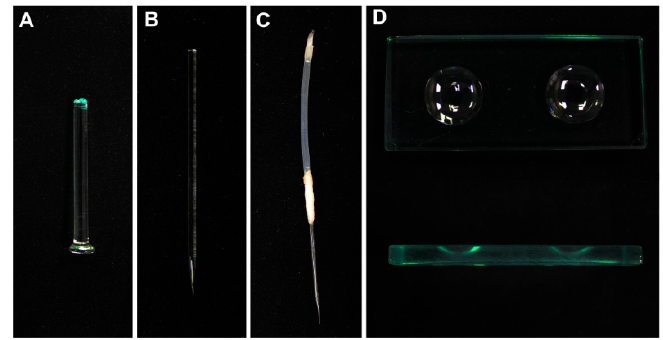
Figure 1. Tools used for the isolation of living tobacco embryos and the terminal deoxynucleotidyl